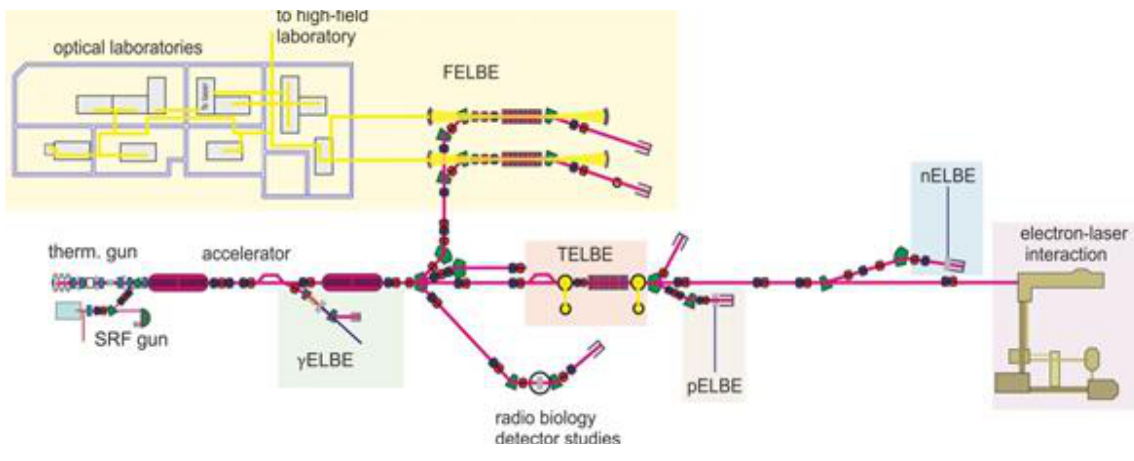
Figure1: Layout of the ELBE Center accelerator and beamlines: FELBE: infrared radiation from Free Electron Lasers; gELBE: Bremsstrahlung; TELBE: coherent THz radiation; pELBE: positrons; nELBE: neutrons, direct electron beams for radio biology and detector studies; Petawatt lasers Draco and Penelope with electron - laser interaction